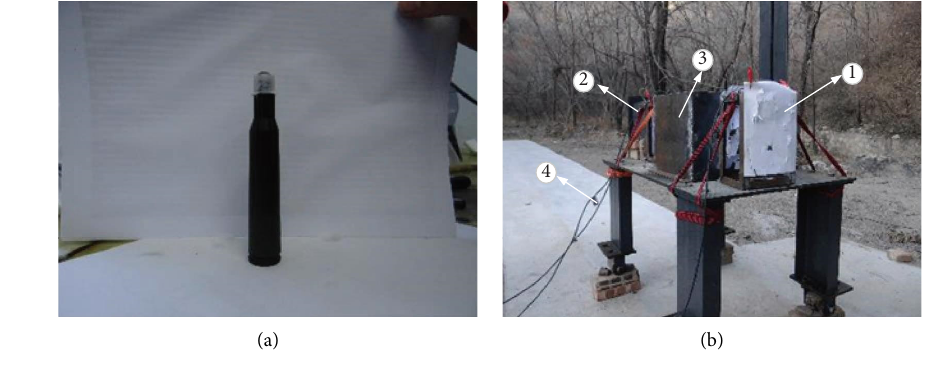
Figure 4: Physical diagram of a test device. Table 5: Test conditions.